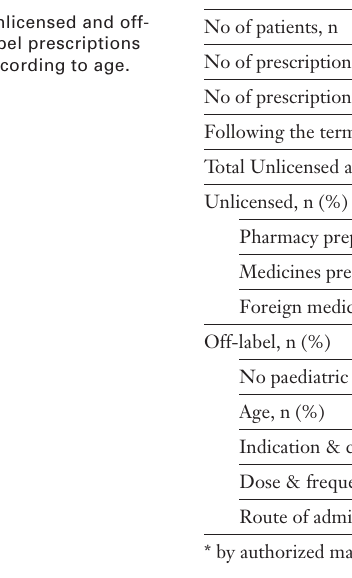
The 10 drugs most frequently used in an unlicensed and off-label manner in the